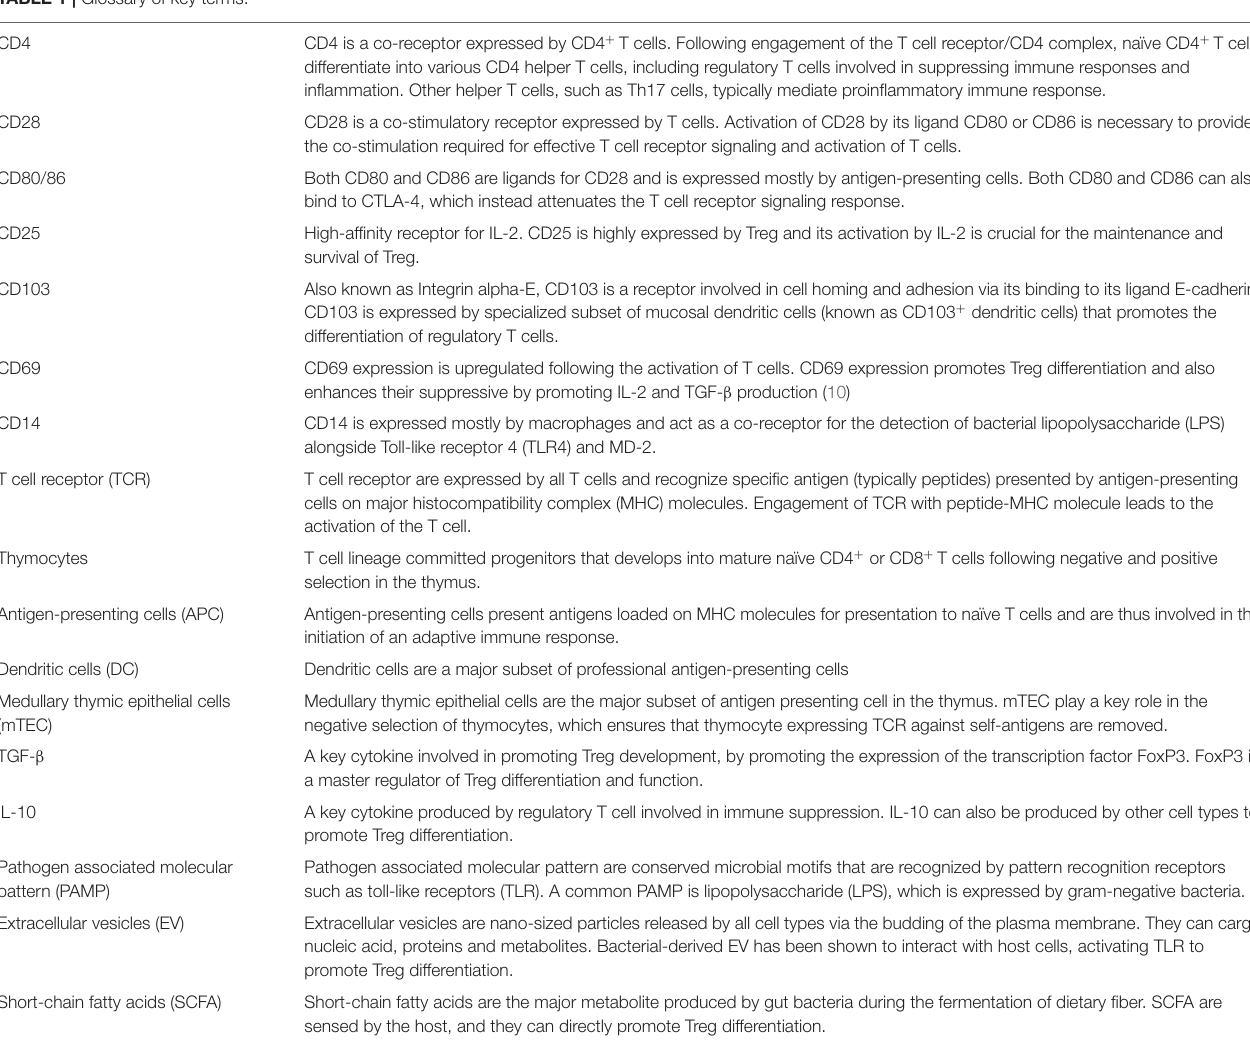
TABLE 1 | Glossary of key